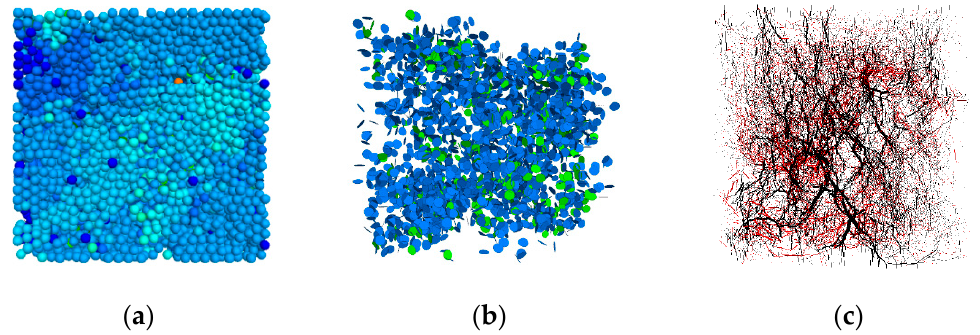
Figure 28. The crack development inside the model of the foamed concrete with a density of 600 kg/m 3 at a loading rate of 6 mm/min. ( a ) model failure mode; ( b ) crack development; ( c ) force-chain distribution.